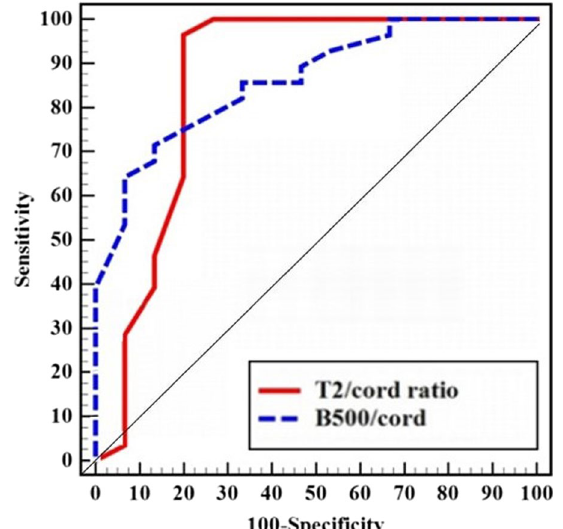
Fig. 10 ROC curve for T2WI and b500-DWI L-to-cord signal intensity